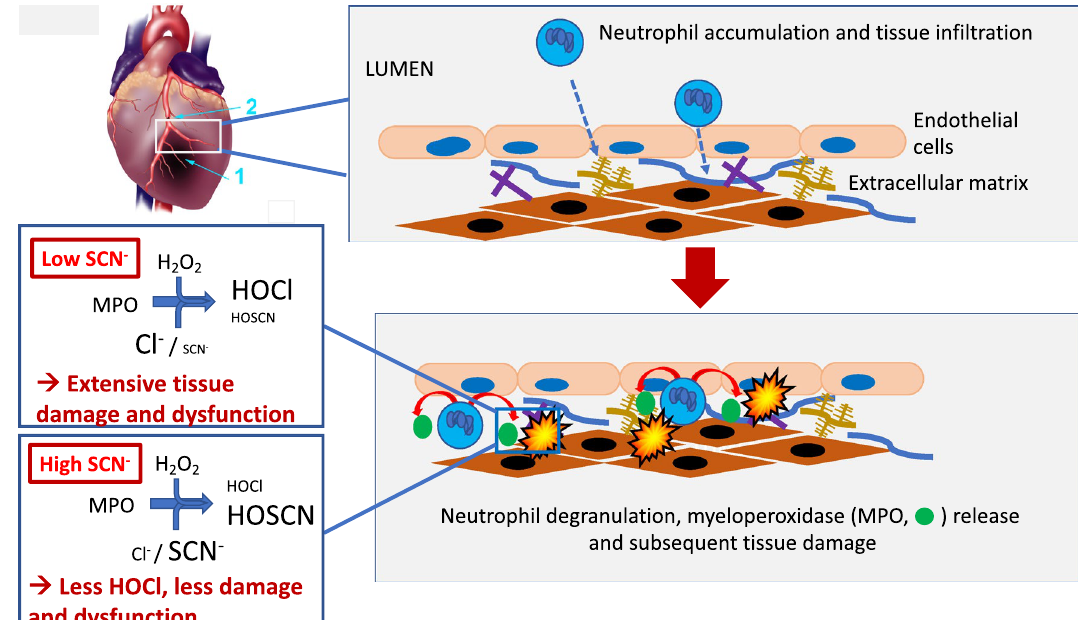
Figure 11. Proposed model of protection by SCN − against IR injury. Occlusion of the left anterior descending artery in rats gives an area of ischemia (1). The site of ligation (2) in indicated. Subsequent release of the ligature results in reperfusion of this area. The restoration of blood flow results in a rapid infiltration of leukocytes, predominantly neutrophils during the initial period, that accumulate in the damaged tissue. Activation of these cells, results in the formation of superoxide radicals (O 2 − . , via the action of NADPH oxidase-2) and H 2 O 2 (from O 2 − . dismutation), and release of the heme enzyme myeloperoxidase (MPO). MPO utilizes H 2 O 2 and chloride ions to give the potent oxidant and tissue-damaging species, hypochlorous acid (HOCl). SCN − is a competing substrate for MPO, and elevation of the levels of this anion decreases HOCl formation. Supplementation of SCN − is shown here to limit tissue damage and dysfunction, with this resulting in: reduced infarct size and increased salvage of the area at risk (as determined by MRI imaging); increased left-ventricle end diastolic and systolic areas (echocardiography); decreased modification of tissue proteins and increased collagen content (antibody recognition and histological staining); and decreased metabolic abnormalities (NMR metabolomics). No effects of SCN − on serum markers of inflammation and tissue damage were detected. Heart image adapted, with permission, from Wu et al. 4